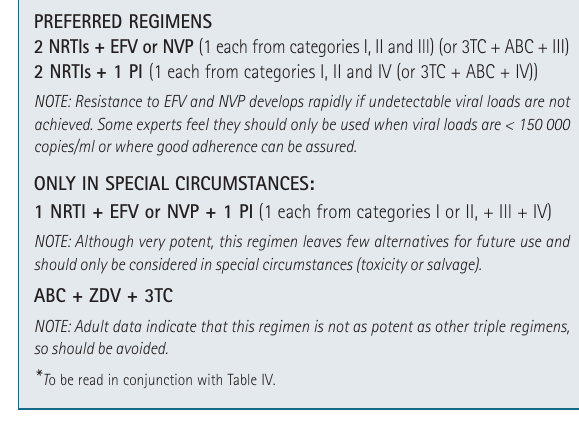
TABLE VI. RECOMMENDED ARV REGIMENS*